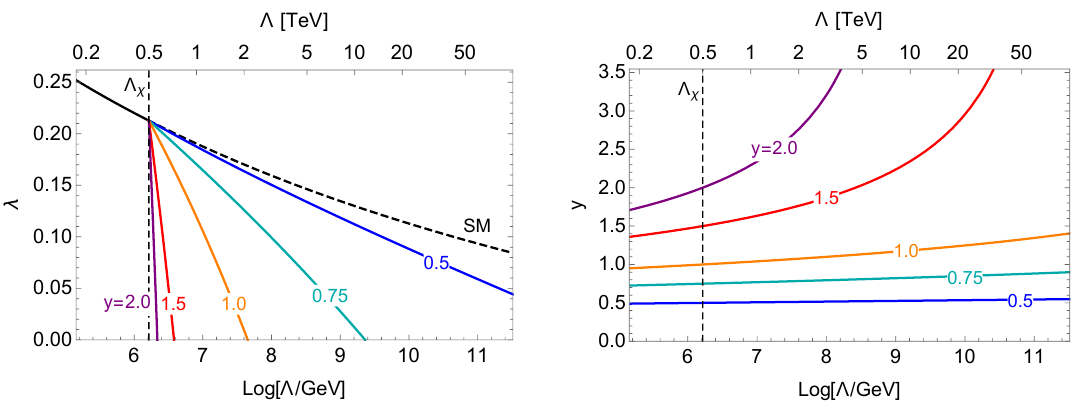
Figure 5 . Renormalization group evolution of the quartic Higgs coupling (cid:21) ( t = log (cid:3)) (left) and the dark Yukawa coupling y ( t ) (right) in the dark fermion model. The energy scale of the dark sector is (cid:12)xed at (cid:3) (cid:31) = 500 GeV. Colored curves correspond with di(cid:11)erent values of y (log (cid:3) (cid:31) ). The dashed black curve shows the evolution of (cid:21) in the